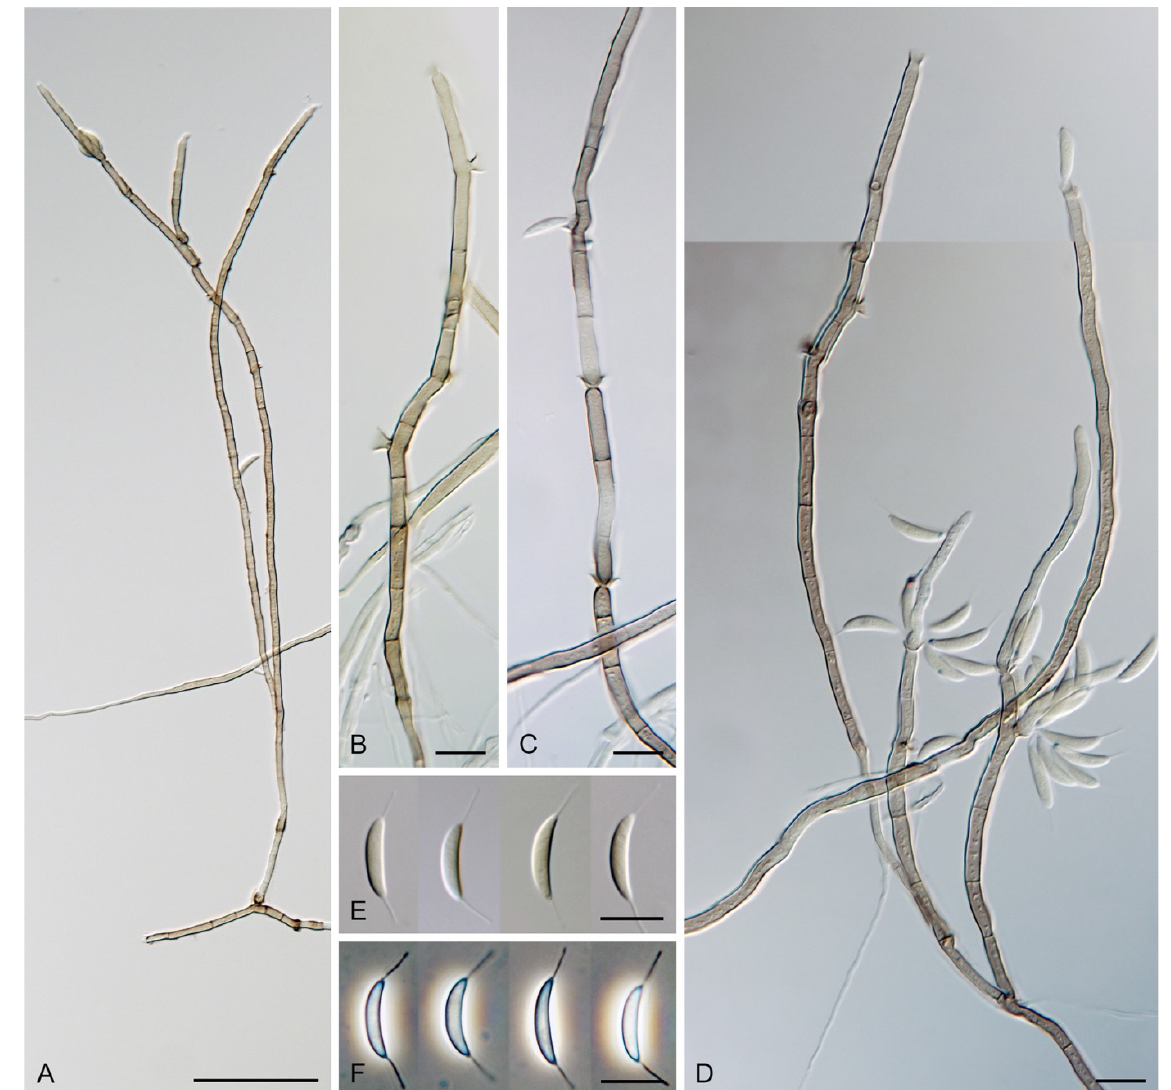
Figure 23. Codinaeella lamberiae (CBS 143419 ex-type). ( A – D ) Conidiophores ( E , F ) conidia. Images: ( A – D ) on OA after 4 weeks. Scale bars: ( A ) 50 μ m; ( B – F ) 10 μ m.